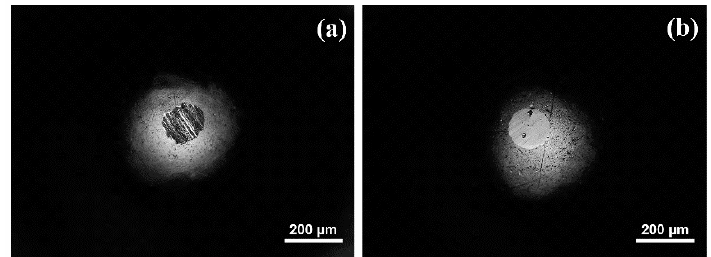
Figure 12. Wear scars on AISI 316L balls: ( a ) lubricated with base oil; ( b ) lubricated with the dispersion.